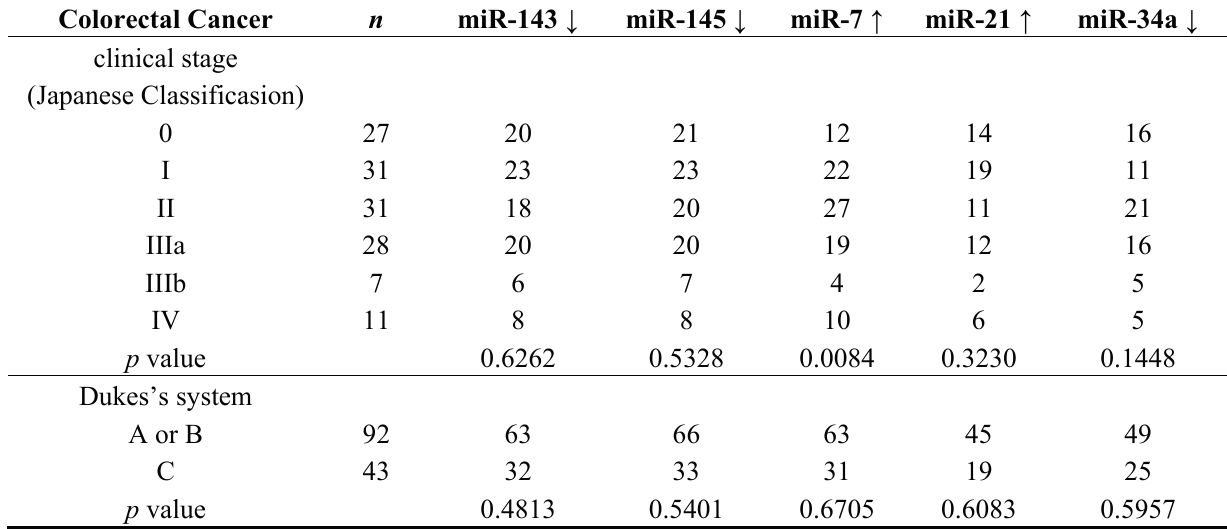
Table 2. Expression of miR -143, -145, -7, -34a, and -21 in human colorectal cancer tissues as evaluated by performing TaqMan ® Real-time PCR assays (clinical stage and Dukes’ system). Colorectal Cancer